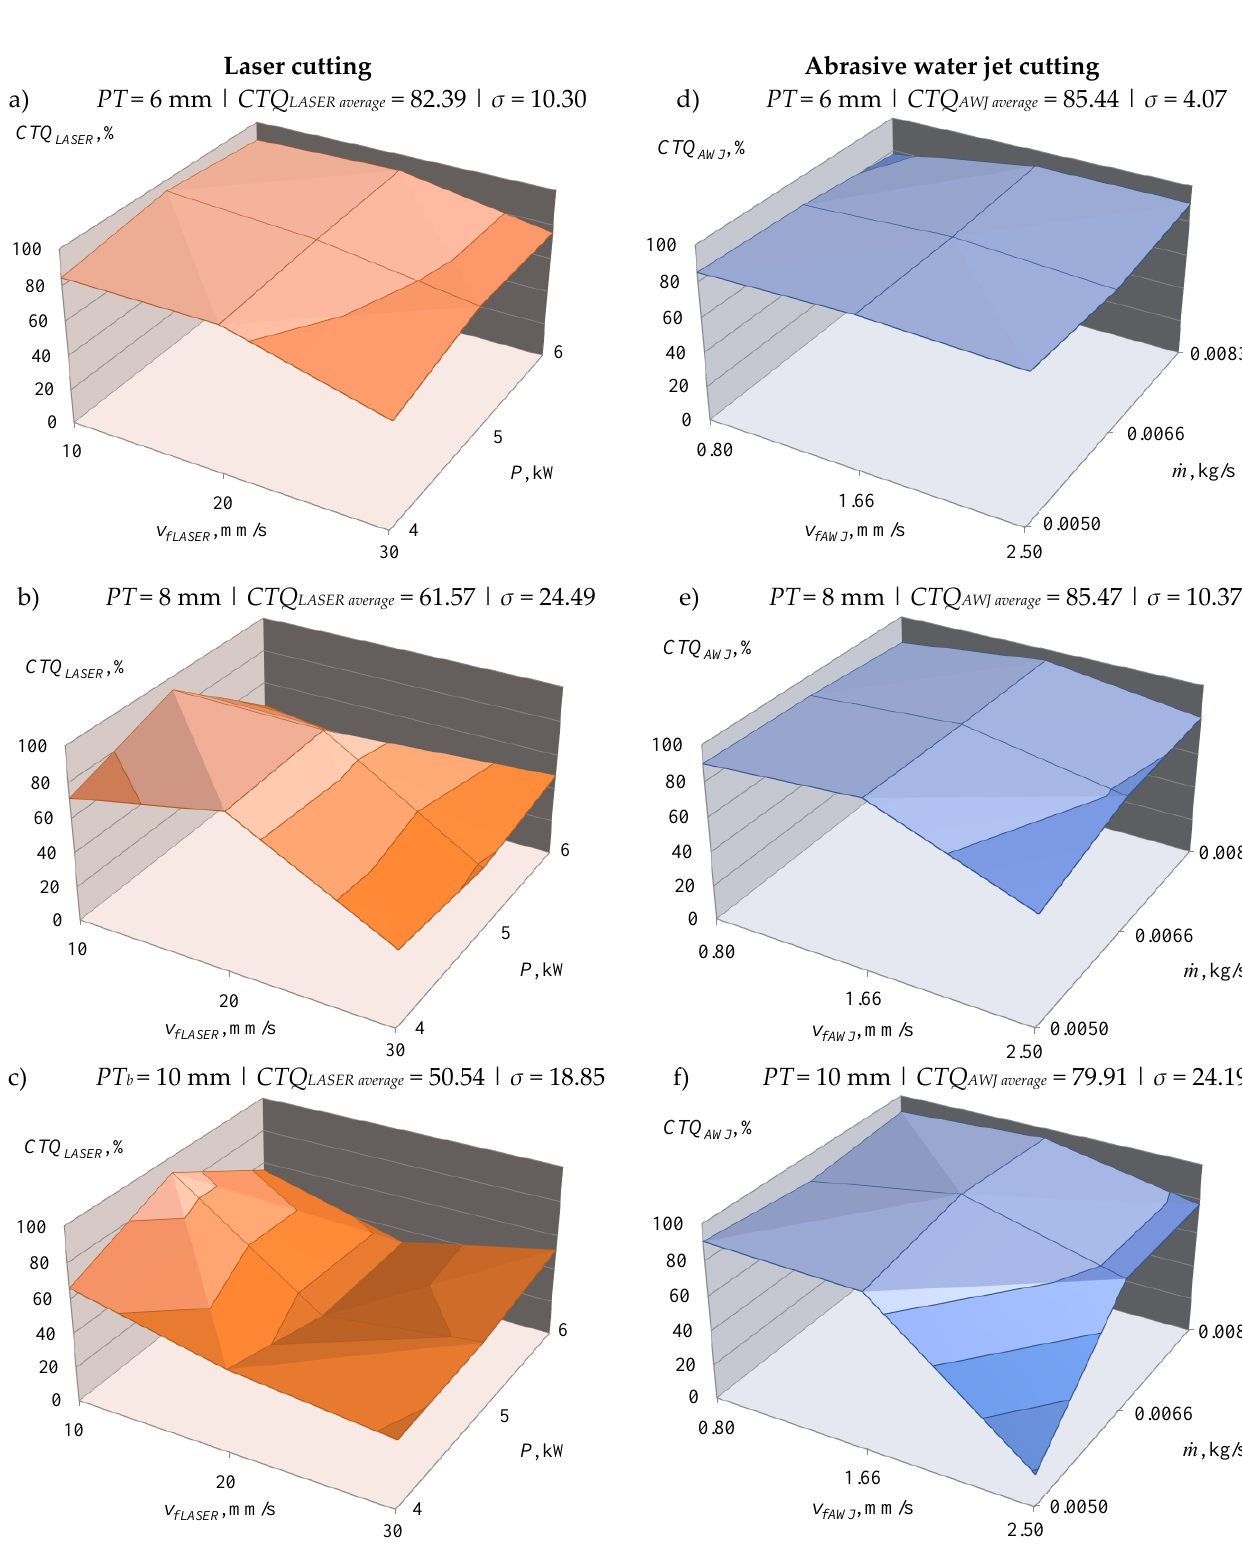
Figure 8. Changes in CTQ values of the surface after cutting plates with thicknesses PT of 6 mm ( a , d ), 8 mm ( b , e ) and 10 mm ( c , f ) depending on the variable power P and cutting head feed rate v f LASER in laser cutting process ( a – c ) as well as variable abrasive flow rate ˙m cutting head feed rate v f AWJ in abrasive water jet cutting process ( d – f ) ( σ –standard Table 4. List of the values of factors (before and after normalization) enabling the determination of cutting technological quality index after laser cutting CTQ LASER (subscripts n denote values after normalization).